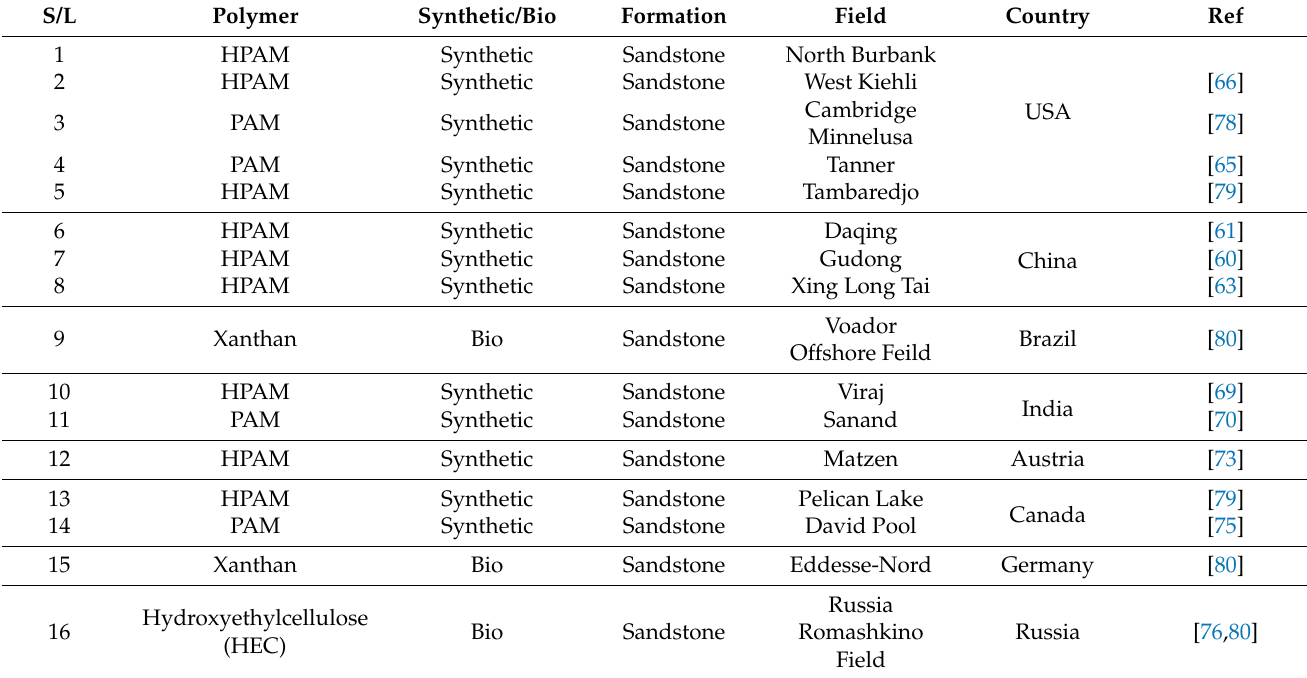
Table A2. Field Application of Polymer.